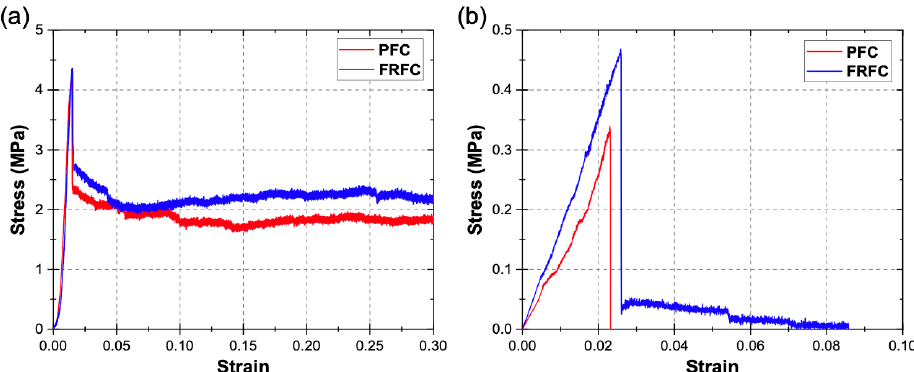
Figure 2. ( a ) Typical uniaxial compression stress-strain curves for plain foamed concrete (PFC) and fiber-reinforced foamed concrete (FRFC) and ( b ) typical uniaxial tension stress-strain curves for PFC and FRFC.